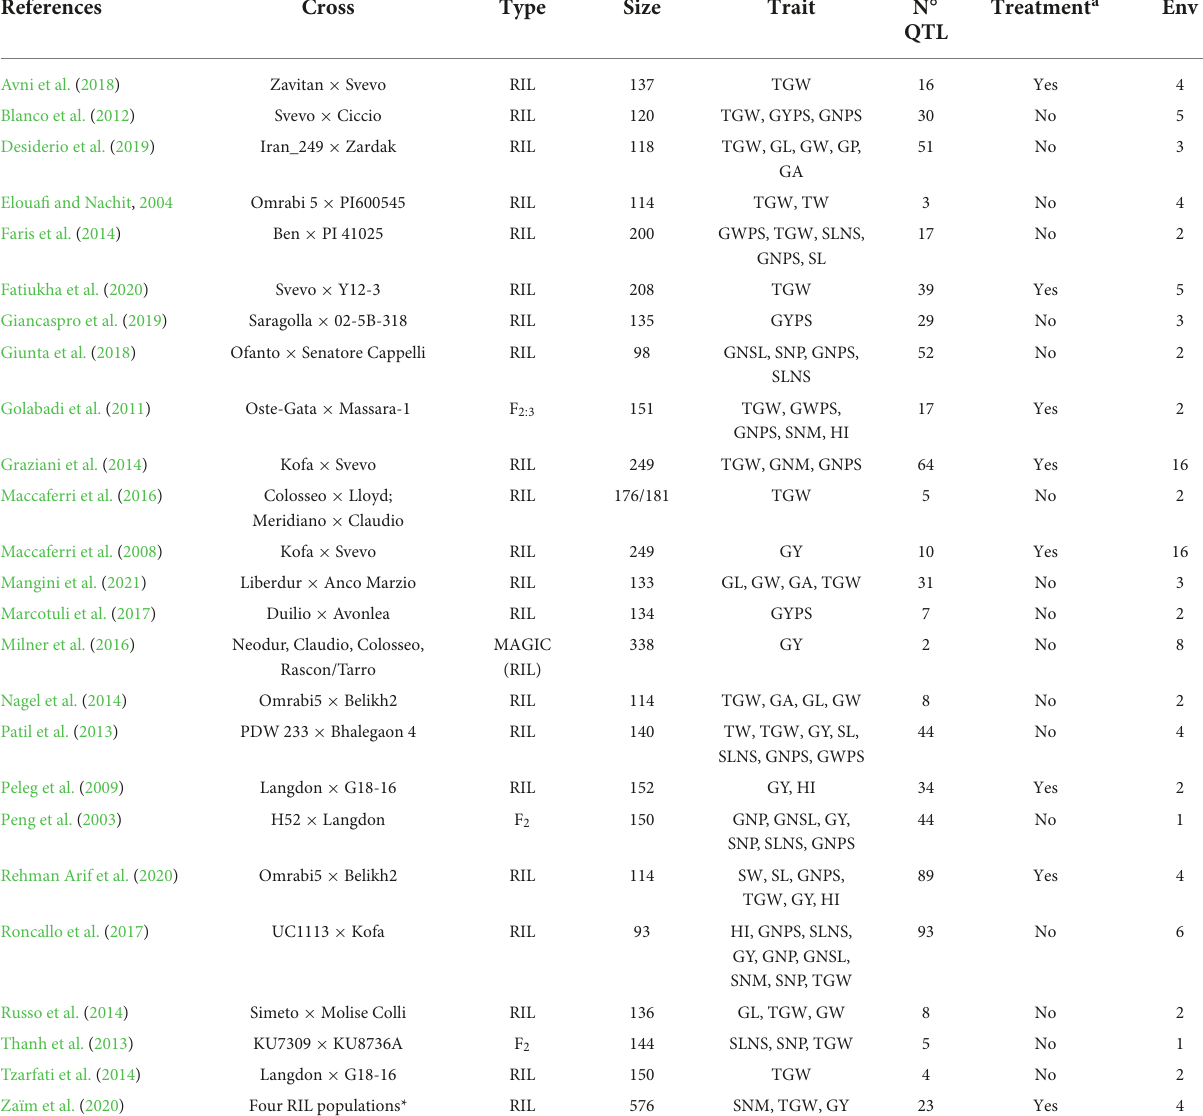
TABLE 2 Summary of the QTL studies reviewed including reference, mapping populations, type of population, size, traits, number of QTL collected, water regime, and the number of